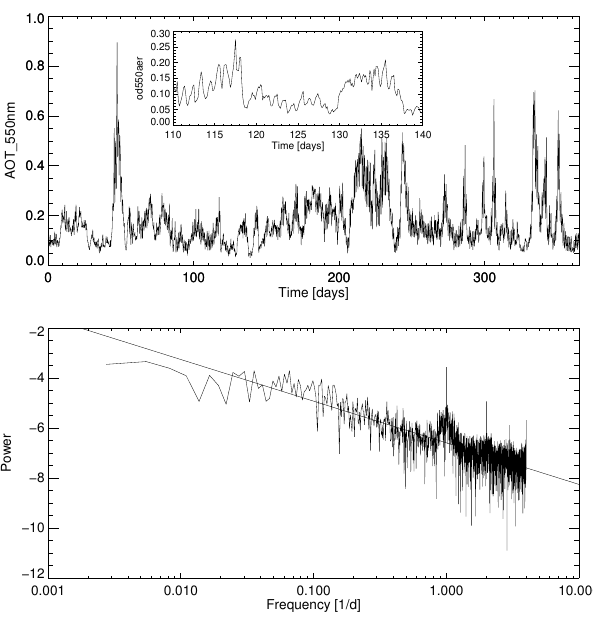
Figure 3. AOT time series and its associated power spectrum at 75 ◦ W, 0 ◦ N in HadGEM-UKCA. For this power spectrum, the ratio of power at 1day over total power is ∼ 0.01. The straight line in the lower plot has a slope of − 5 /